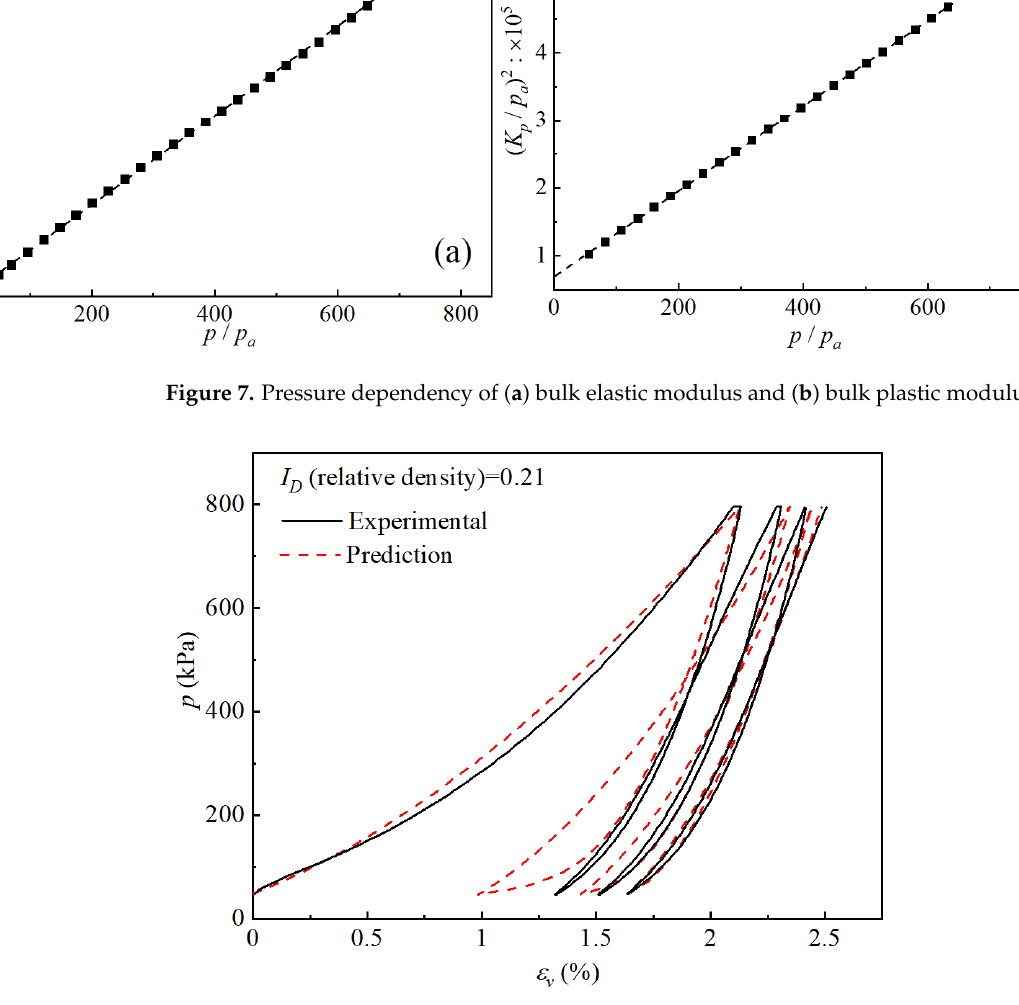
Figure 8. Comparison of prediction with experimental results of Karlsruhe fine sand in the cyclic isotropic compression test. Table 2. Parameters for empirical formulations in